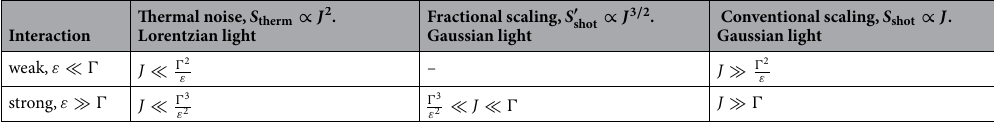
Table 1. Noise regimes classification